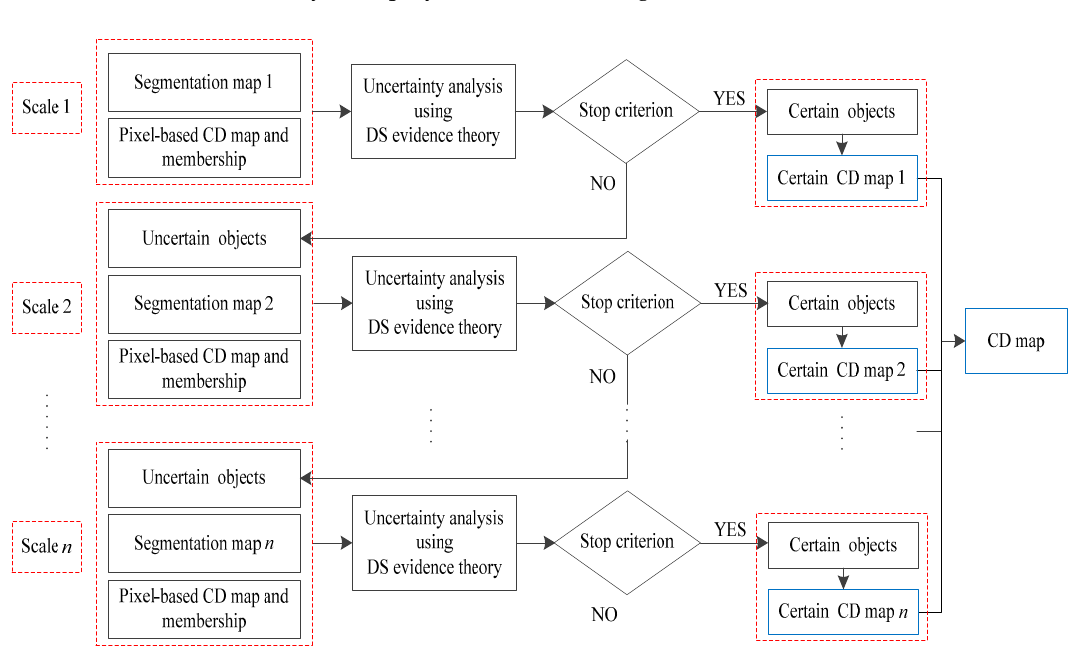
Figure 2. Process of the scale-driven CD incorporating uncertainty analysis.